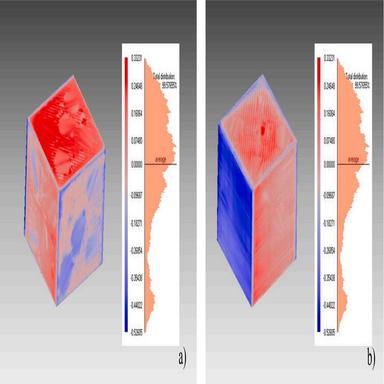
W14 cube: a) and b) variances distribution from two view points; c) punctual variances.